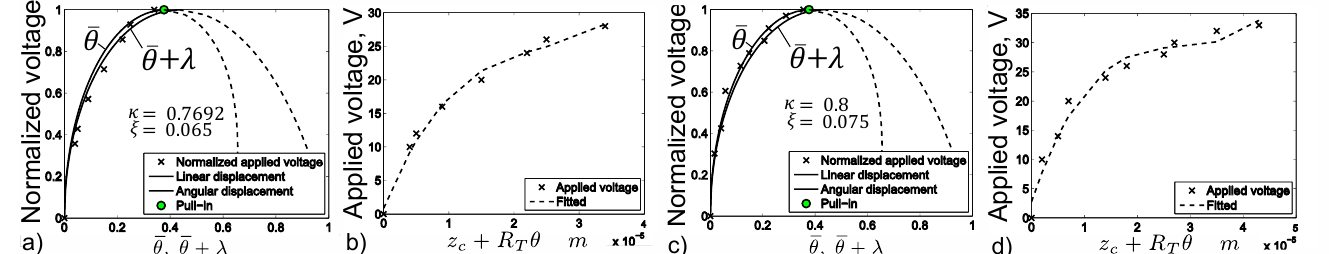
Figure 5. The results of modeling together with measured data in the normalized values: ( a ) measurement I; ( c ) measurement II. Applied voltage vs. the linear displacement of the disc: ( b ) measurement I; ( d ) measurement II (other details are shown in Table